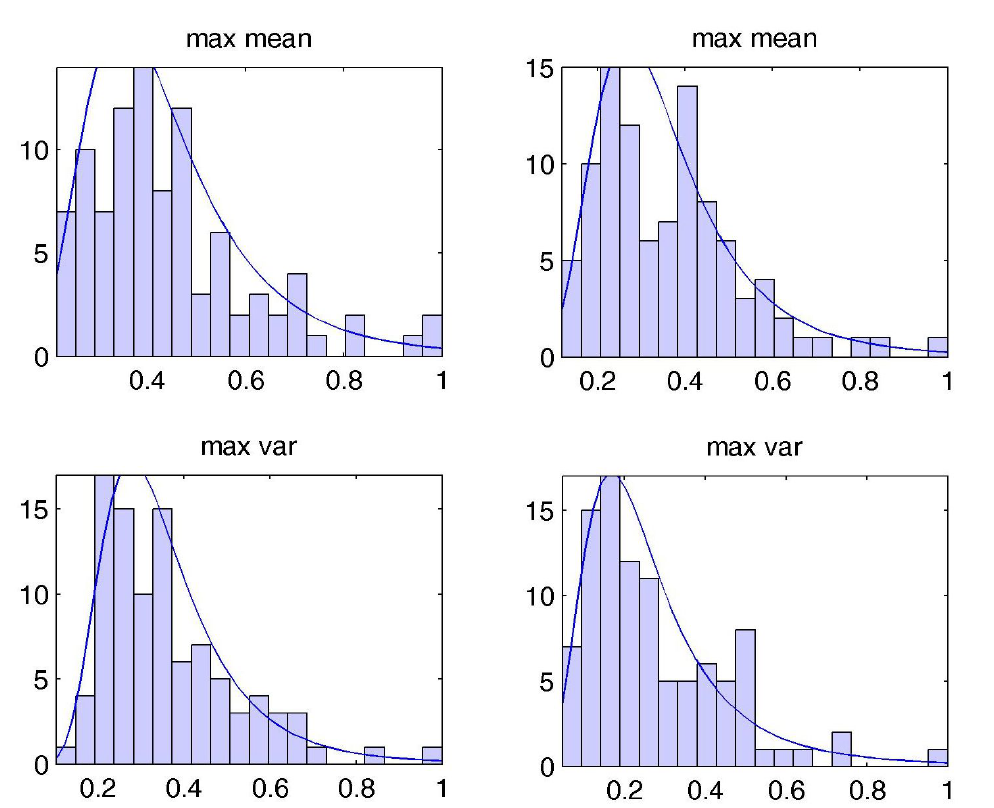
( j ) and V (cid:48) ( j ) values. ( a ) Experiment. ext ext